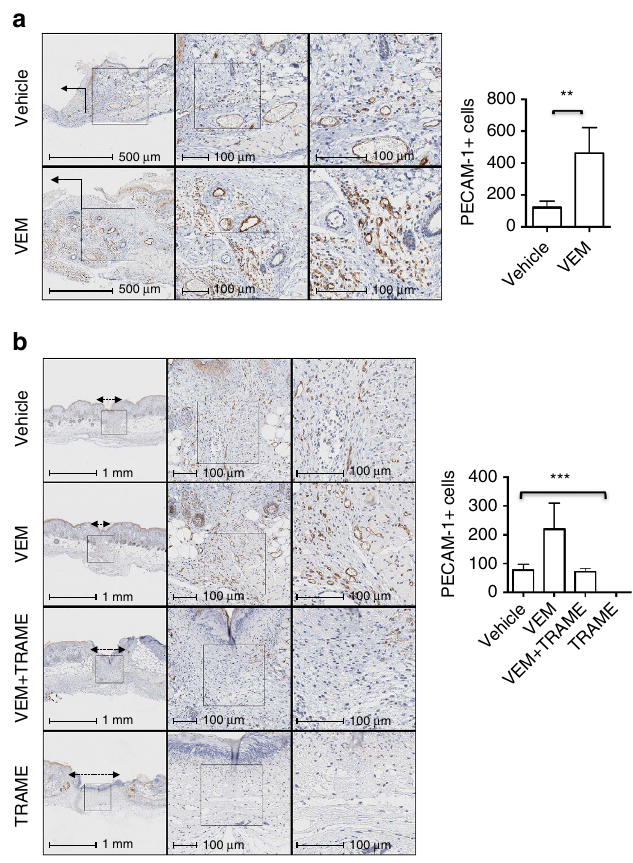
Figure 6 | Angiogenesis is increased in mice wounds treated with vemurafenib. ( a ) Representative photomicrograph immunohistochemistry images of PECAM-1 þ cells in an excisional wound splinting model of mice treated with vehicle or vemurafenib on day 6 post-treatment and bar graph, on the right side, representing the quantification of PECAM-1 þ cells on the vehicle- and vemurafenib-treated wounds on day 6 ( P ¼ 0.006 by t -test; n ¼ 4). Wound area indicated with an arrow. ( b ) Representative photomicrograph immunohistochemistry images of PECAM-1 þ cells in an incisional wound model of mice treated with vehicle, vemurafenib (VEM), trametinib (TRAME) or the combination (VEM þ TRAME); ( P ¼ 0.0002 by one-way ANOVA). Trametinib alone completely depleted the number of PECAM-1 þ cells. Wound area between double head arrows. Error bars, mean ± s.d. Bar graphs represent one experiment with 4 replicates per